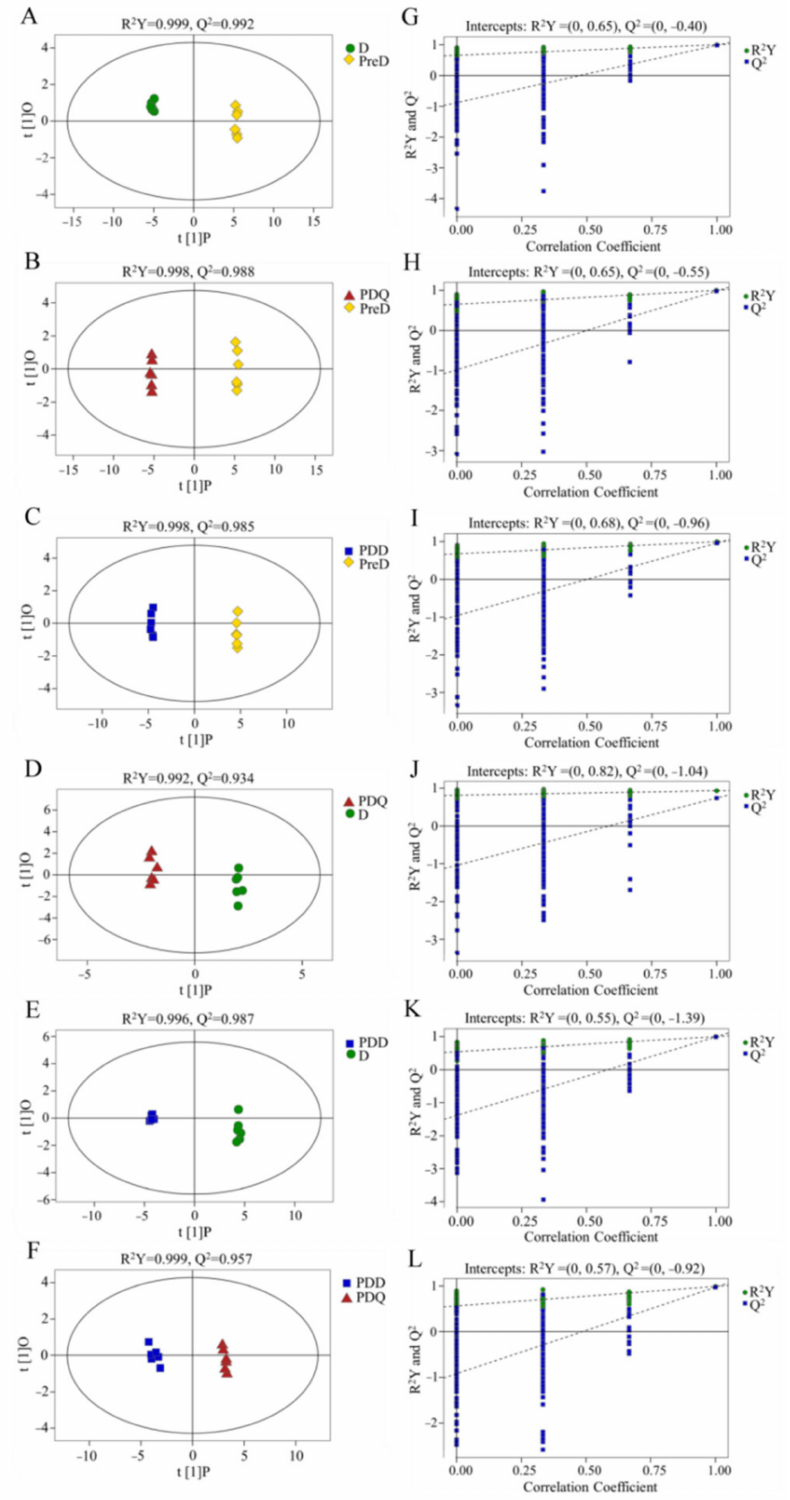
Figure 2. Orthogonal partial least squares discriminant analysis (OPLS-DA) score plots ( A – F ) and the corresponding permutation tests ( n = 200) ( G – L ) of the metabolic profiles of pair comparisons of the four groups, including pre-diapause (PreD), diapause (D), post-diapause quiescence (PDQ) and post-diapause developmental larvae (PDD) of Sitodiplosis mosellana